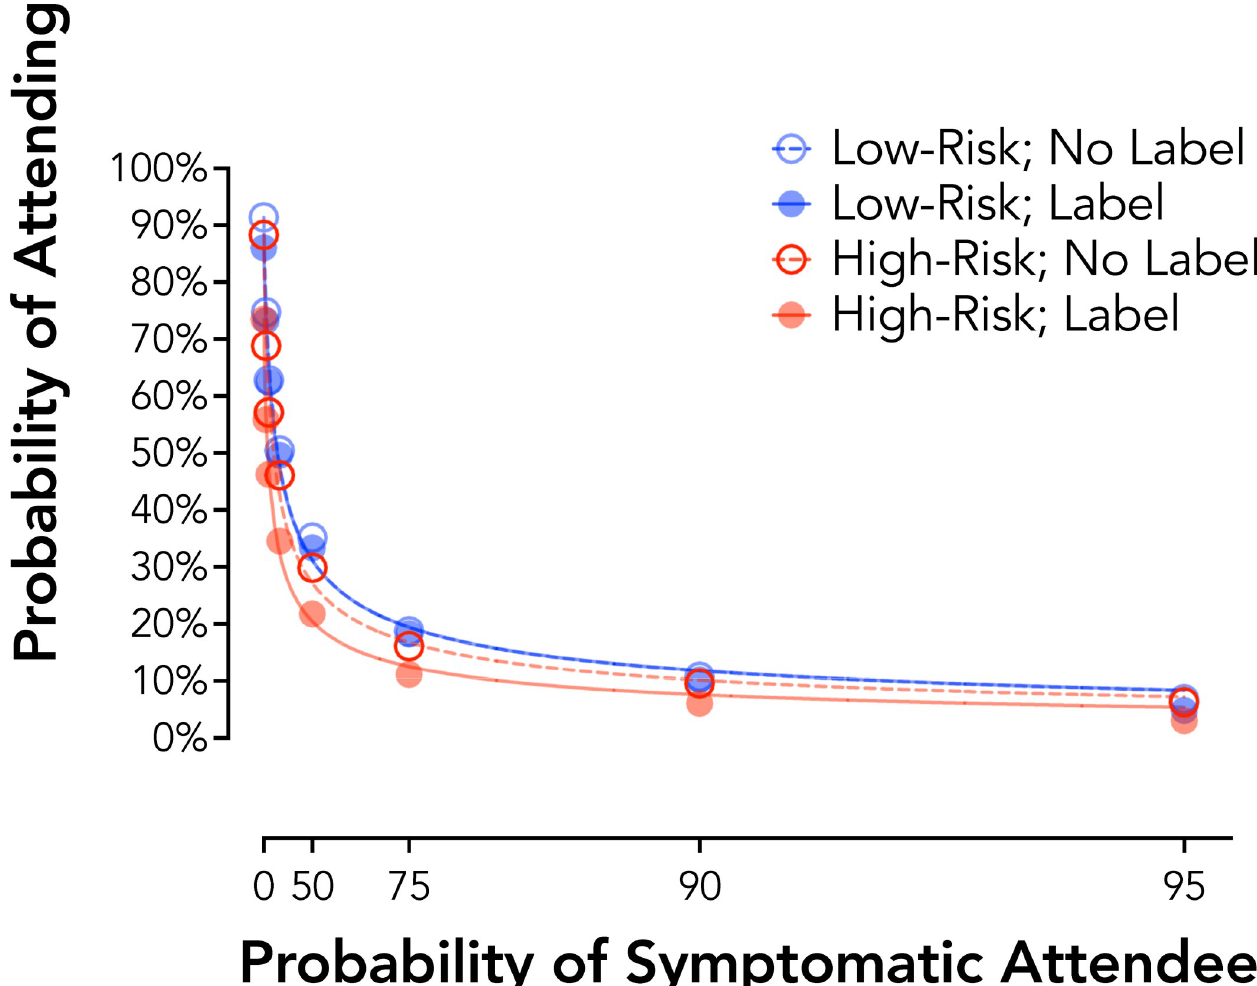
Fig 2. Probability discounting of social event attendance by risk framing (Experiment 2). Plotted are group discounting curves by risk (low risk activity = blue circles; high risk activity = red circles) and label type (no label = open circles, dotted line; label = closed circles, solid line). X axis values are computed as odds in favor of a symptomatic attendee. Curves are plotted using the hyperbolic discounting equation including a non-linear scaling parameter [43].